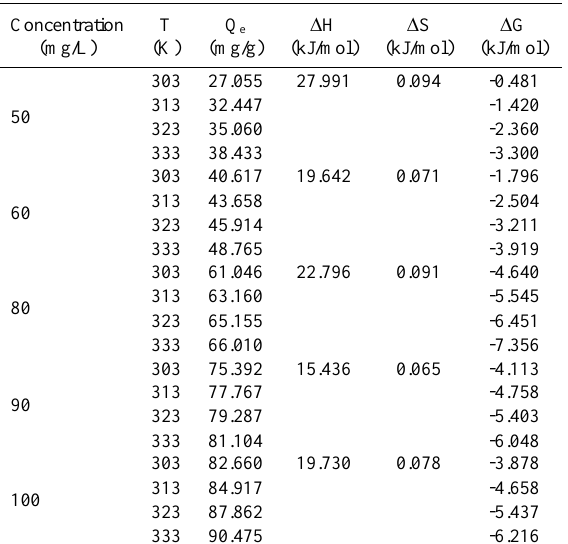
Table 5. Thermodynamic parameter of adsorption malachite green onto Mg/Cr